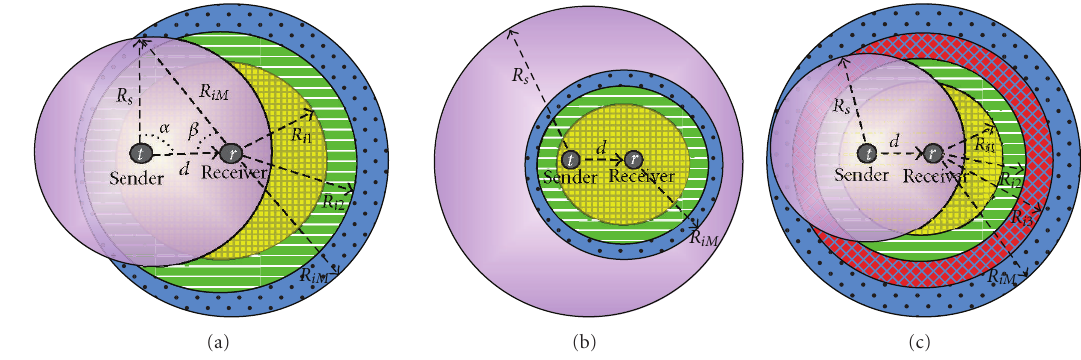
Figure 1: Hidden node area under di ff erent